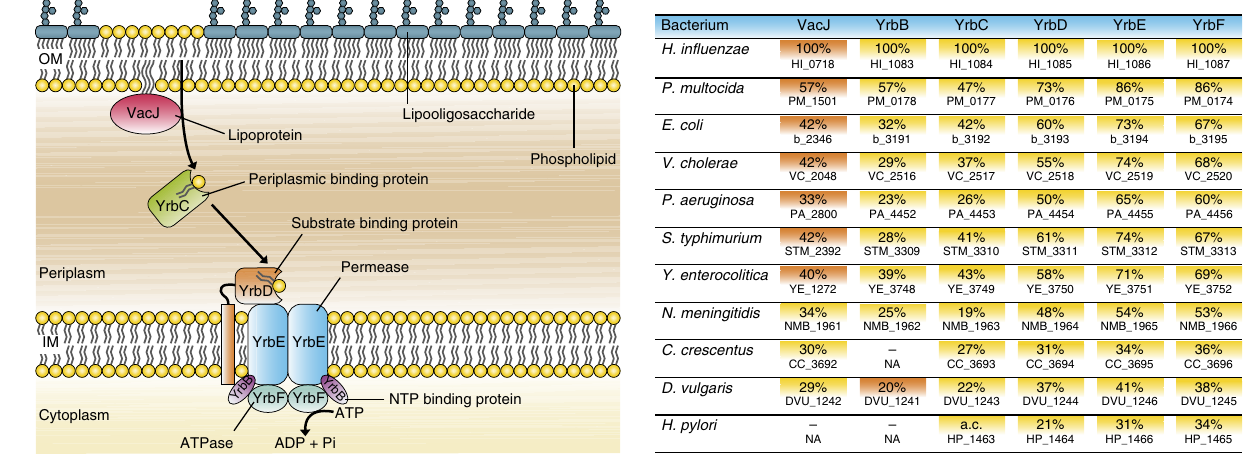
Figure 1 | A conserved ABC transport system putatively prevents PL accumulation in the outer leaflet of the OM. ( a ) The VacJ and Yrb proteins of H. influenzae are homologous to members of the E. coli Mla pathway, which has been proposed to maintain the lipid asymmetry in the Gram-negative OM by retrograde trafficking of PLs from the OM to the inner membrane (IM) 24 . The model is derived from the Mla pathway model proposed by Malinverni and Silhavy 24 . ( b ) Conservation of H. influenzae VacJ and Yrb proteins among Gram-negative bacteria. The respective genes or gene clusters were identified via the SSEARCH programme in combination with the SSDB (Similarity Sequence DataBase) using the KEGG database resource. Shown are the corresponding gene numbers and the respective amino acid sequence identities (in percentage), which were determined by BLASTp and/or Clustal Omega. Adjacent genes located in gene clusters are highlighted in yellow, genes located outside of the yrb gene clusters are coloured orange. In case of a single dash and NA (not applicable) no conserved homologous protein was identified. In Helicobacter pylori an auxiliary component (a.c.) with no homology to any other component is encoded within the yrb gene cluster. Genomes analysed were: H. influenzae Rd KW20 ( g ), P. multocida Pm70 ( g ), E. coli K-12 MG1655 ( g ), V. cholerae O1 El Tor N16961 ( g ), P. aeruginosa PAO1 ( g ), Salmonella enterica serovar Typhimurium LT2 ( g ), Yersinia enterocolitica 8081 ( g ), N. meningitidis MC58 ( b ), Caulobacter crescentus CB15 ( a ), Desulfovibrio vulgaris Hildenborough ( d ) and H. pylori 26695 ( e ). The symbols a , b , g , d and e refer to the class of the respective bacterium within the phylum Proteobacteria